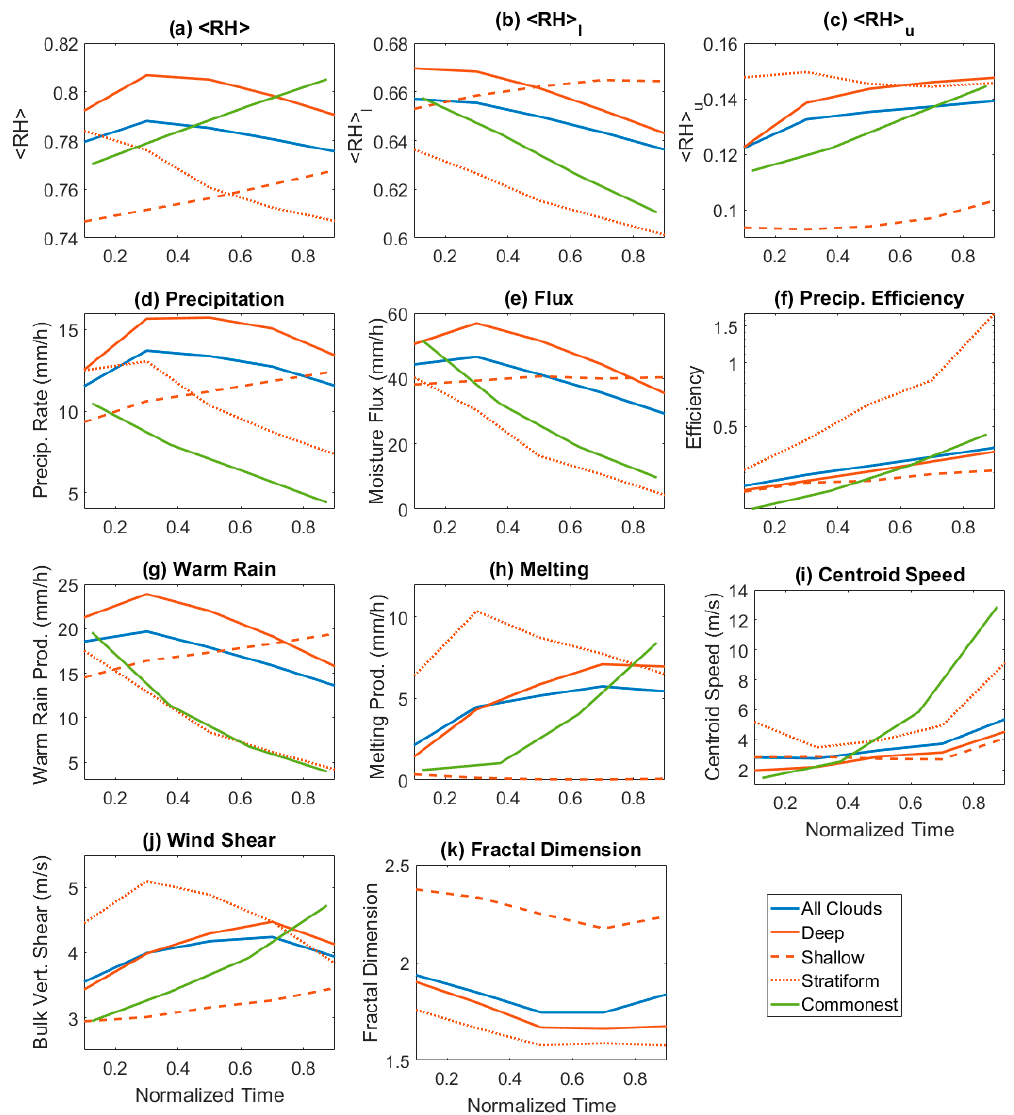
Figure 3. Mean normalized temporal evolutions of various cloud and environmental quantities for tracked clouds for all cloud (blue), various cloud types (reds), and for the clouds exhibiting the most common pattern (green; see Figure 4). The various panels indicate the normalized evolutions of ( a ) <RH>, ( b ) <RH> l , ( c ) <RH> u , ( d ) the precipitation rate, ( e ) the moisture flux, ( f ) the precipitation efficiency, ( g ) the warm rain generation, ( h ) the generation of rain due to melting, ( i ) the speed of the motion of the centroid location, ( j ) the magnitude of mean wind shear, and ( k ) the fractal dimension of the cloud.